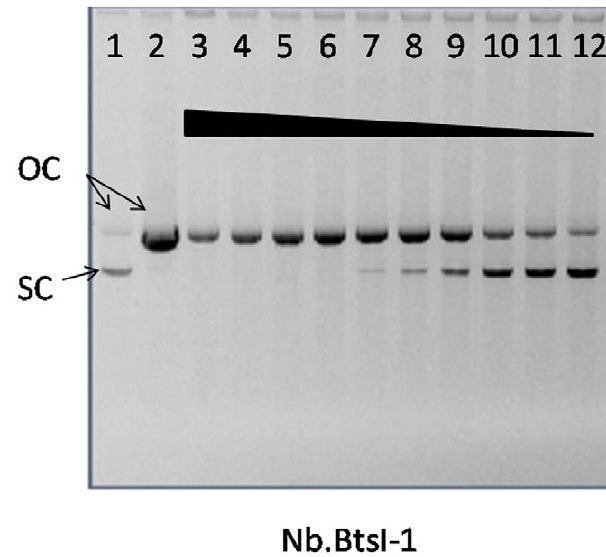
Figure 7. Nicking activity of Nb.BtsI-1 on substrate phiX174 RF I. A 2-fold serial dilution of Nb.BtsI-I was used to digest phiX174 RF I at 55 u C for 1 hour (lane 3–20). Lane 1 is uncut phiX174 RF I. Lane 2 is uncut phiX174 RF II (Nicked, circular form of phiX174). OC: open circular; SC: super coil.